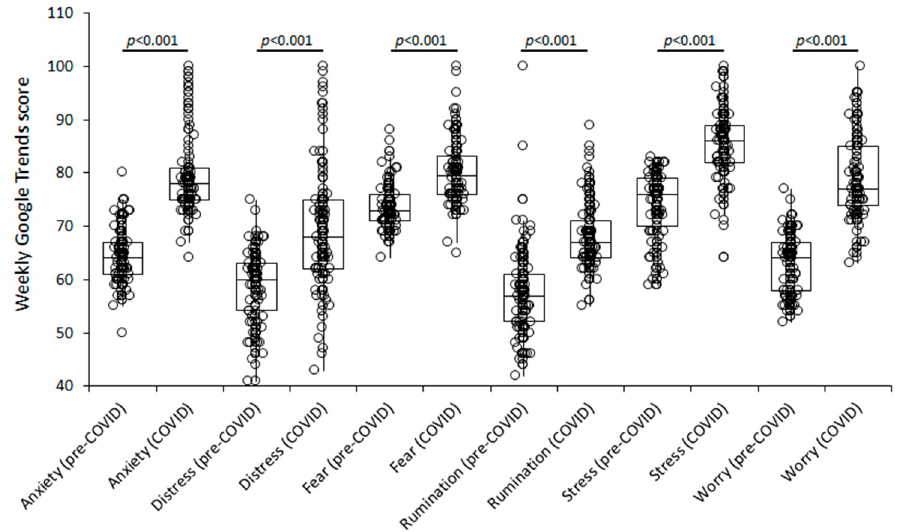
Figure 1. Worldwide weekly Google Trends score of the search terms “Anxiety”, “Distress”, “Fear”, “Rumination”, “Stress” and “Worry” before (“pre-COVID”) and during (“COVID”) the coronavirus disease 2019 (COVID-19) pandemic. Results are shown as median and interquartile range